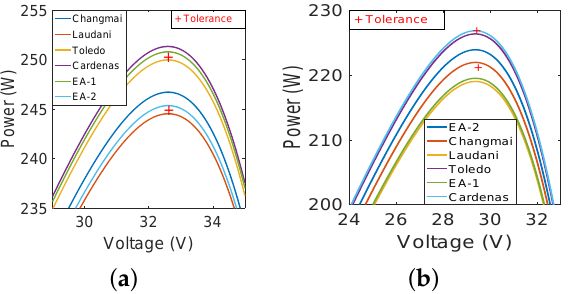
Figure 5. V–P characteristics of 315 Wp PV module applying different algorithms ( a ) at 25 ◦ C and ( b ) 45 ◦ C.